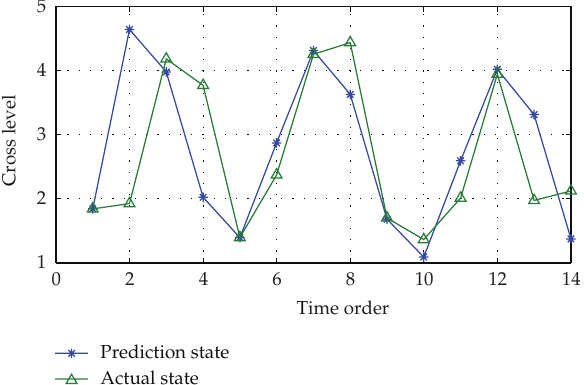
Figure 8: Comparison of actual state and prediction state at unit section after residual